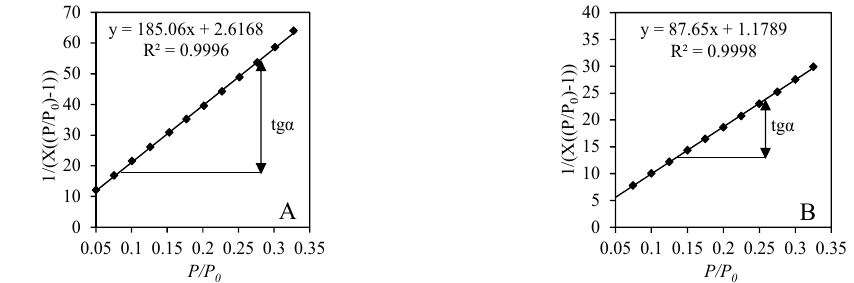
Figure 9. Isotherm of N 2 adsorption at 77 K in BET plot of products after 72-h synthesis from mixtures: lime–GSW ( A ), lime–calcined opoka ( B ).